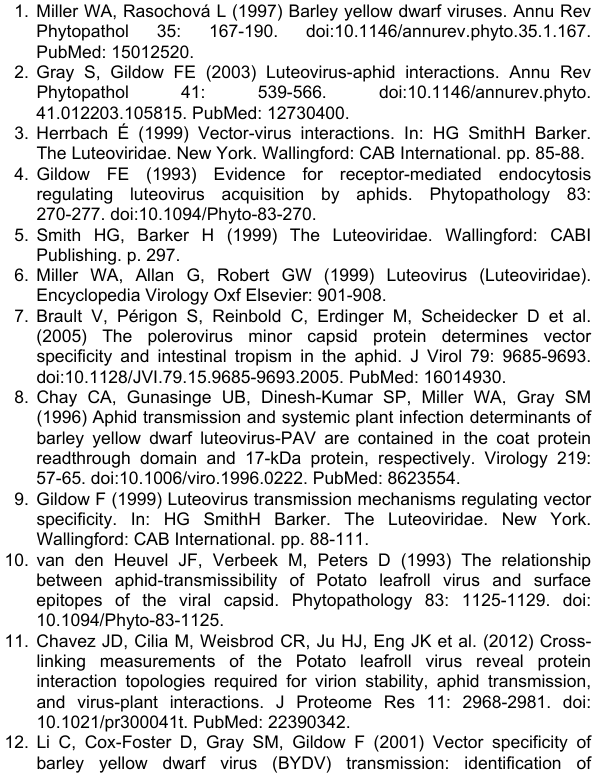
Dataset S2. Spectral counting peptide data from Table 3 for cyclophilin A.